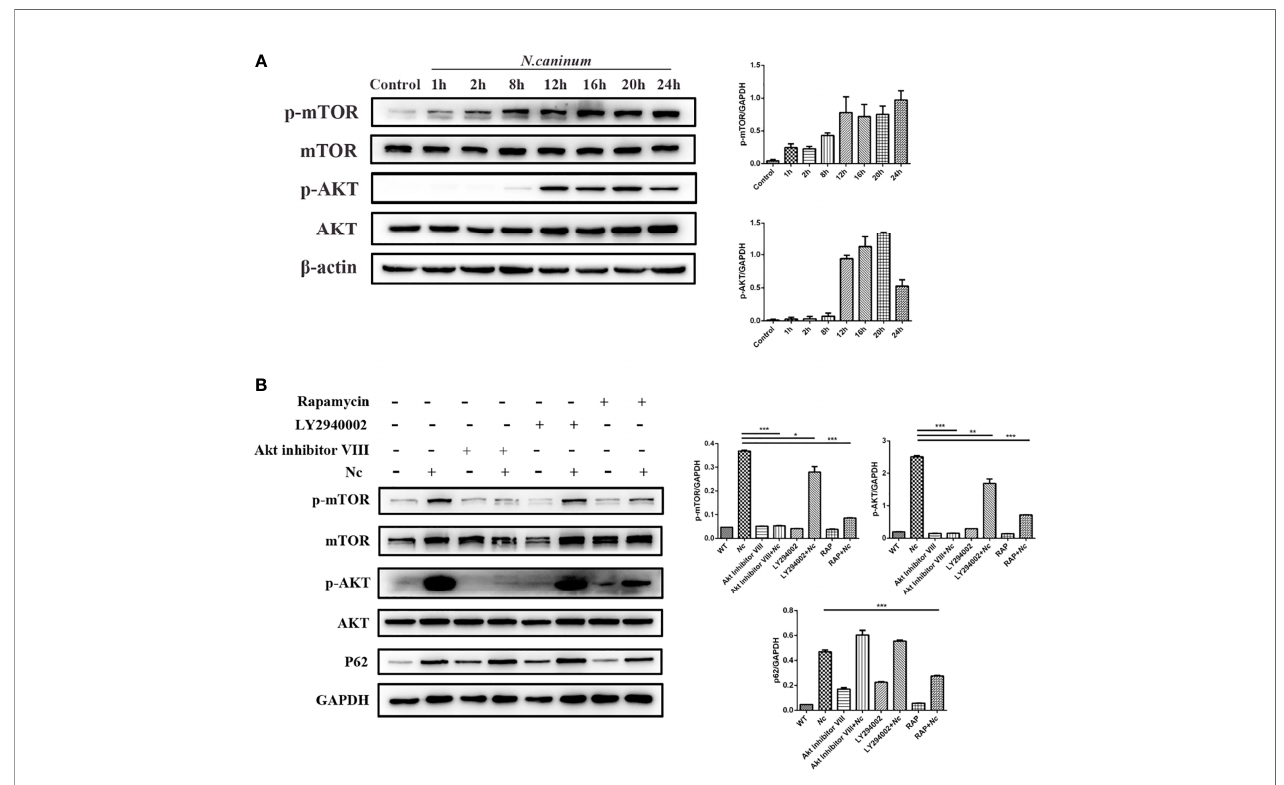
FIGURE 3 | The effect of N. caninum infection on the AKT/mTOR signaling pathway in macrophages. (A) Peritoneal macrophages were infected with N. caninum tachyzoites (MOI = 3), and total protein was extracted at the indicated times. The ratios of p-mTOR, mTOR, p-AKT, AKT, and b -actin were detected by Western blot analysis. (B) The ratios of p62, p-mTOR, mTOR, p-AKT, AKT, and GAPDH were detected by Western blot analysis of cell lysates from peritoneal macrophages pretreated with or without rapamycin (1 m M), LY294002 (25 m M), or AKT inhibitor VIII (1.25 m M) for 1 h prior to infection with N. caninum tachyzoites (MOI = 3). The data shown are representative of three independent experiments. Bar graphs are expressed as the mean ± SEM, * P < 0.05; ** P < 0.01; *** P <